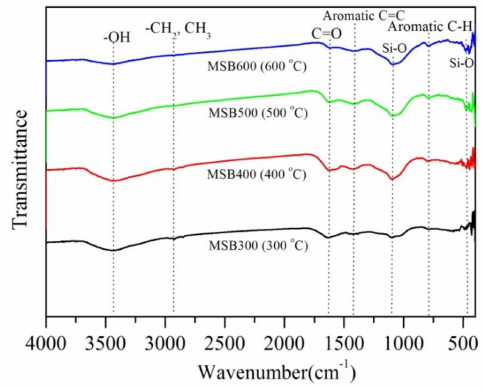
Figure 3. FTIR spectra of MSB pyrolyzed at 300 to 600 ◦ C.